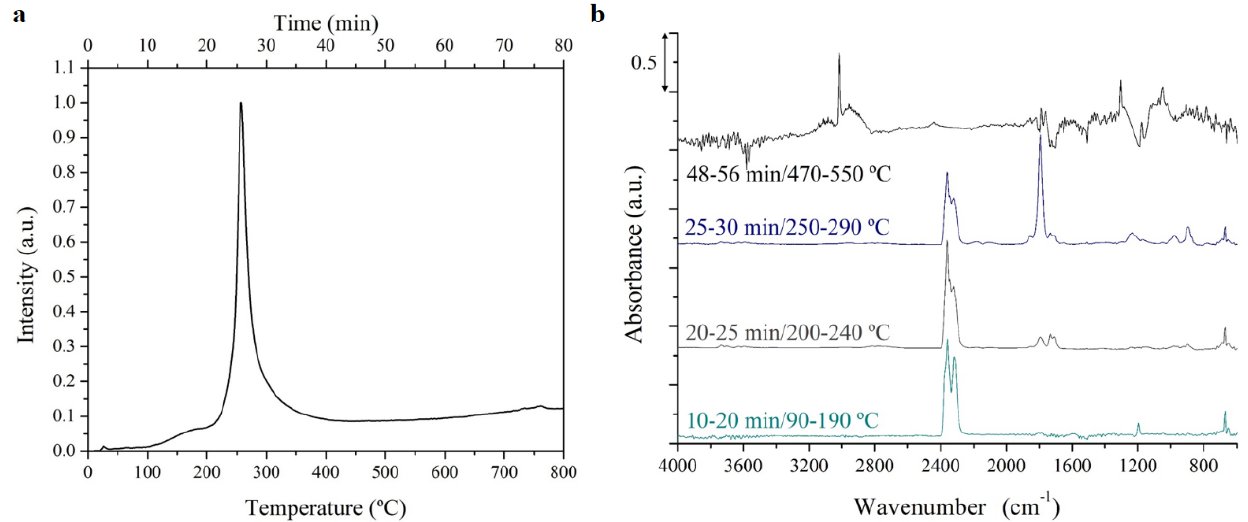
Figure 12. ( a ) Gram–Schmidt over time and temperature and ( b ) FTIR spectra recorded at different intervals for PE1 sample.